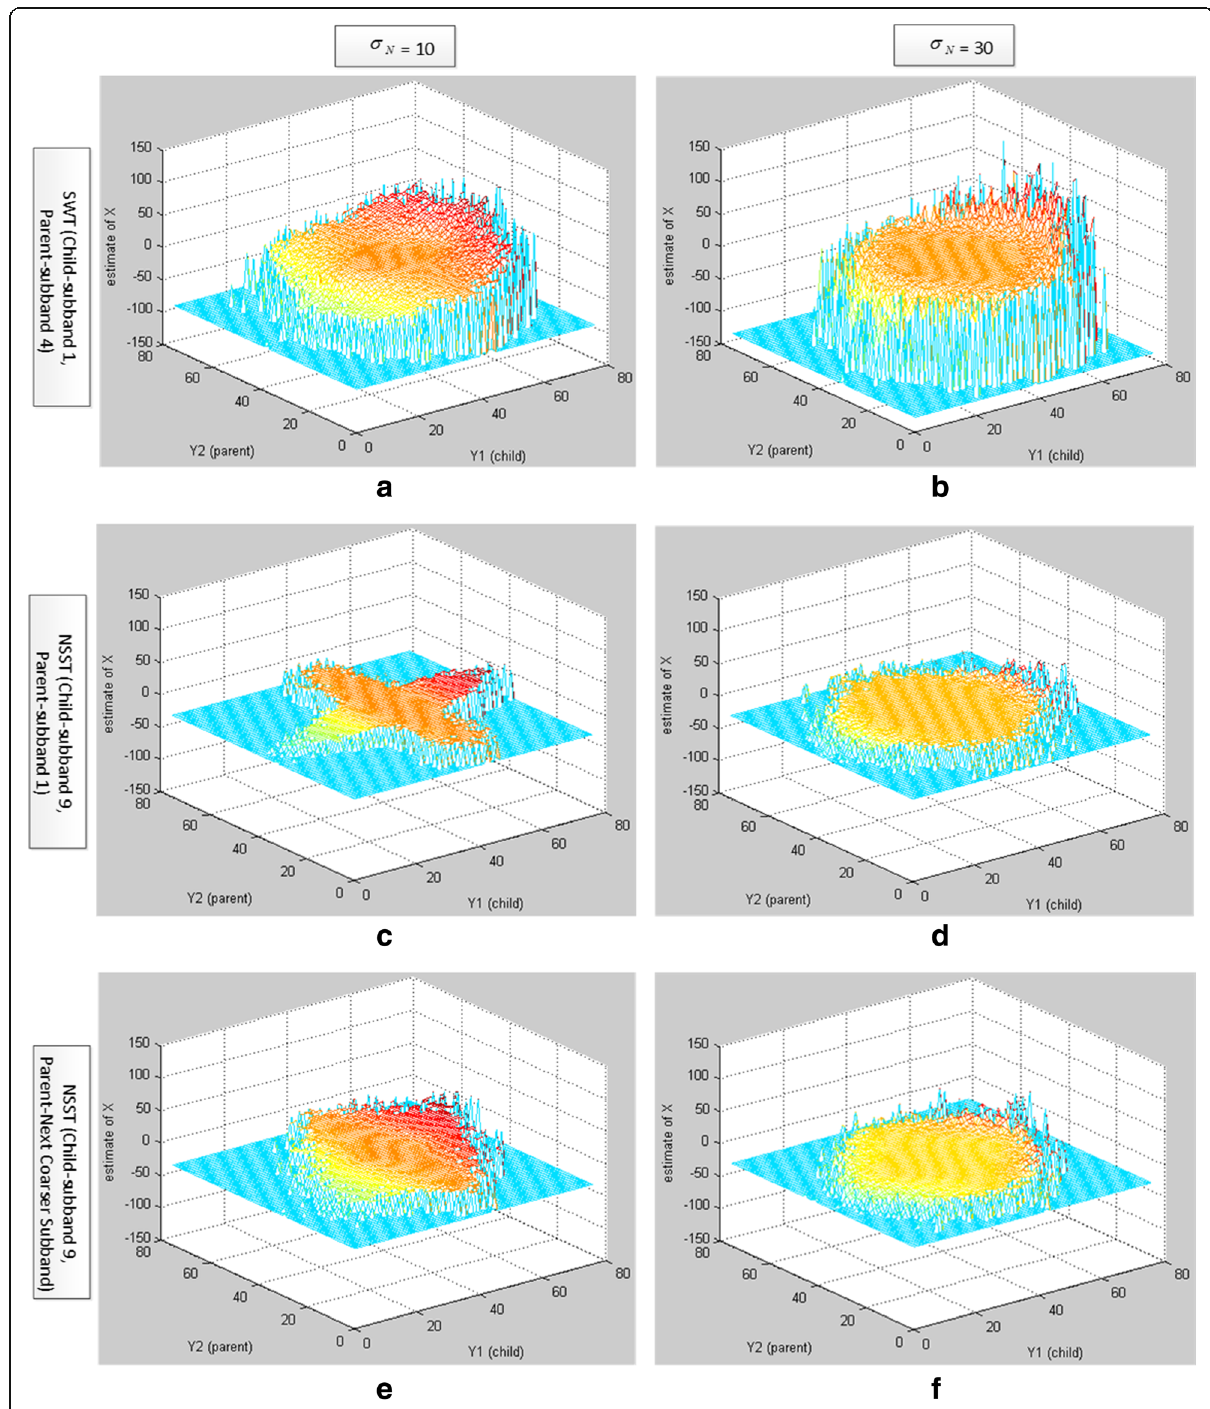
Fig. 2 a – f Dead zone of BiShrink for Barbara in SWT and NSST domains and for two noise